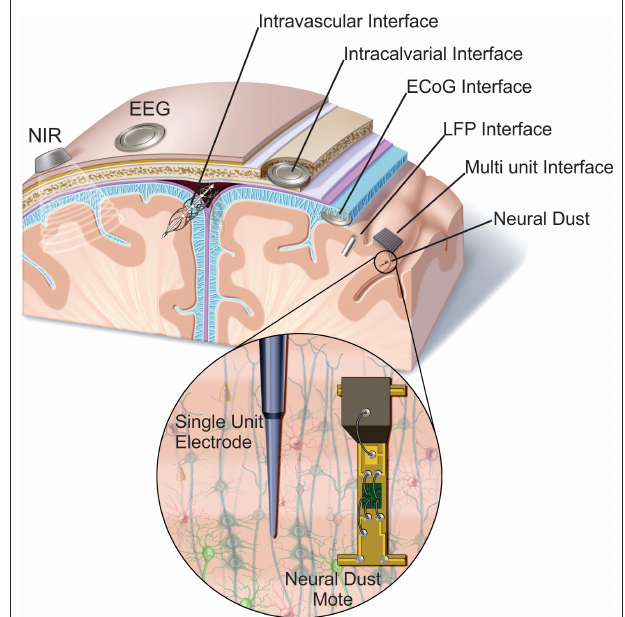
FIGURE 1 | Anatomic locations of representative BCI sensors. BCI form factors have sensors in a diverse number of anatomic locations. Some are on or above the surface of the scalp (near infrared, EEG, and MEG) the others penetrate the body to varying degrees. EEG, electroencephalography;